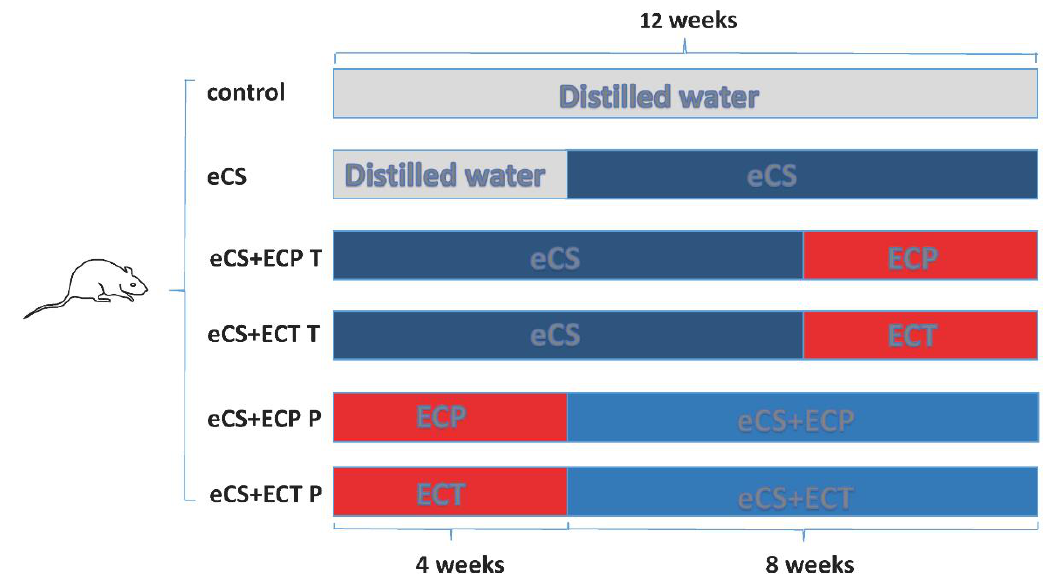
Figure 1. The schematic diagram of experimental